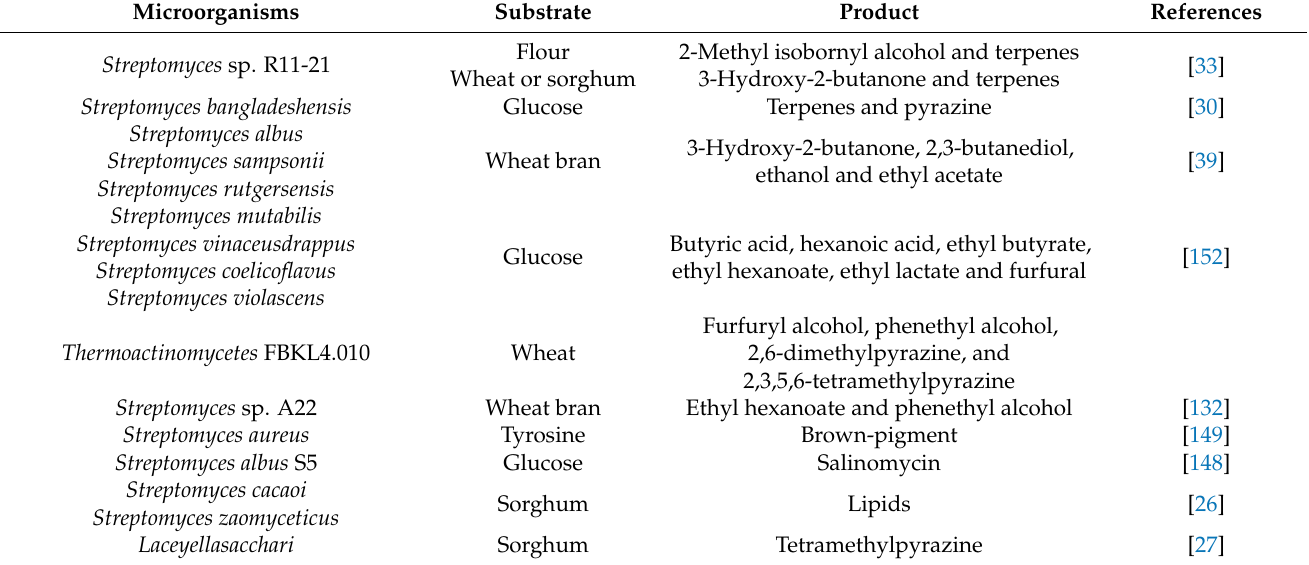
Table 4. Secondary metabolites produced by the actinomycetes isolated from